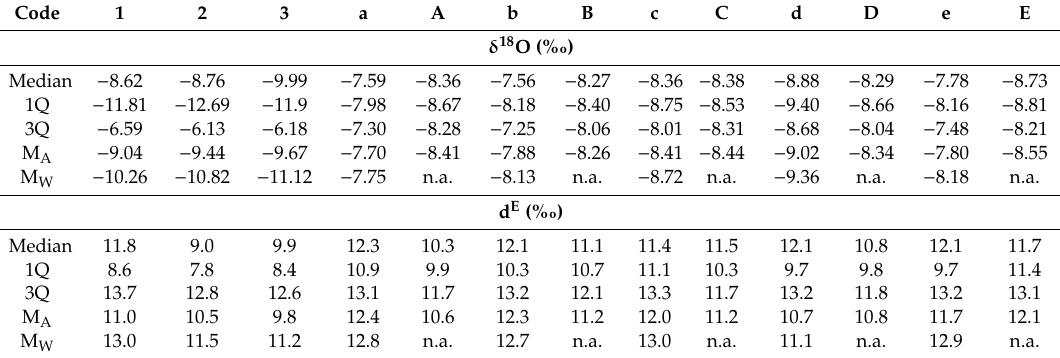
Table 4. Results of the statistical analyses (median, 1st and 3rd quartiles, carried out from δ 18 O and dE time series of precipitations (rain gauges; numbers from 1 to 3), surface water (rivers; letters from a to e) and groundwater from the apical pars of alluvial fans (in form of aggregated isotopic values from wells; capital letters from A to E). Median, 1st and 3rd quartiles are those from box plots (Figure 3). Means (MA and weighted means (Mw) are also reported. For further details, readers are referred to Table 2 (precipitation), Table 3 (surface water) and Table 5